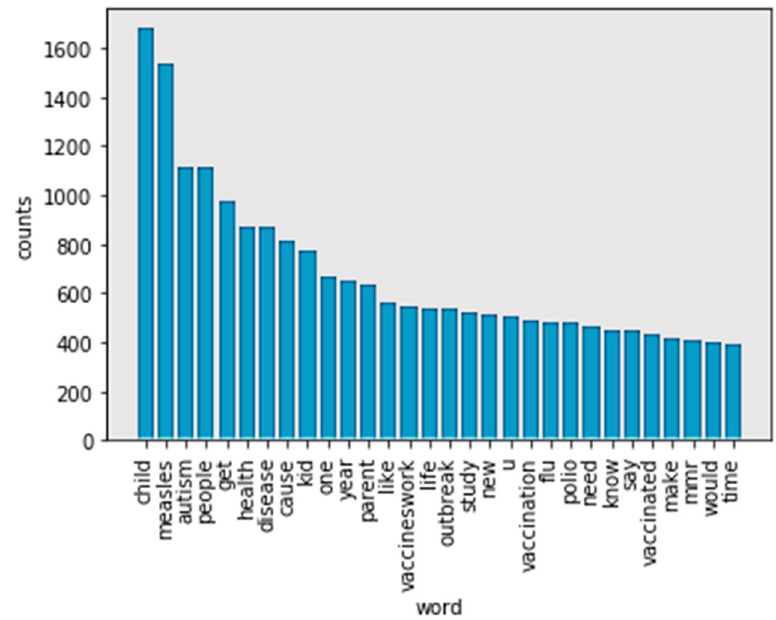
Figure 7. Top 30 frequency words in no-stop words tokens after processing by WordNet.